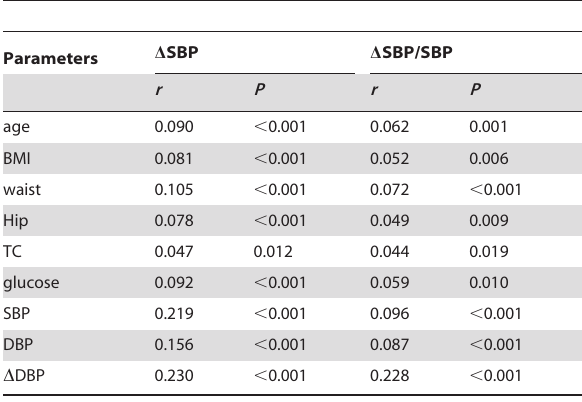
Table 3. The correlation coefficients of D SBP and D SBP/SBP with related factors.